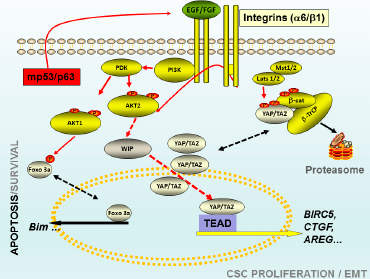
Figure 1. Schematic representation of some elements that play a key role in the tumour-initiating cells (TICs). The Akt 1 isoform may control the viability versus apoptosis in CSCs derived from breast cancer cell lines through the control of FoxO phosphorylation. The knockdown of Akt 1 in these TICs triggered apoptosis through a mechanism FoxO3a-Bim dependent. TICs derived from gliomas, mutations of p53, correlated with high levels of WASP-interacting protein (WIP) protein and Yes-associated protein 1 (YAP)/Transcriptional co-activator with PDZ-binding motif (TAZ). In these TICs the presence of high levels of WIP are essential to maintain the proliferation and CSC-phenotype through mp53 and Akt2. Whereas, high levels of WIP control the high levels of YAP/TAZ, preventing its degradation trough proteasome. Red arrows indicated the pro-oncogenic pathways, black discontinued arrows indicated two potential stages of the same protein; red discontinued arrows indicated not necessarily direct links. Abbreviations: CSC: Cancer Stem cells; PI3K: Phosphoinositide 3-kinase Class I; Akt: viral oncogene protein kinase; Foxo 3a: Forkhead box O3; EGF: Epidermal Growth Factor; FGF: fibroblast growth factor; TEAD: Trancription factor TEA domain member 1; CTGF: Connective tissue growth factor; AREG: Amphiregulin; BIRC5 Baculoviral IAP repeat-containing protein 5; Mst 1/2: Serine/threonine-protein kinase3/4; Lats 1/2: Large tumor suppressor kinase 1/2; β -Trcp: beta-transducin repeat containing